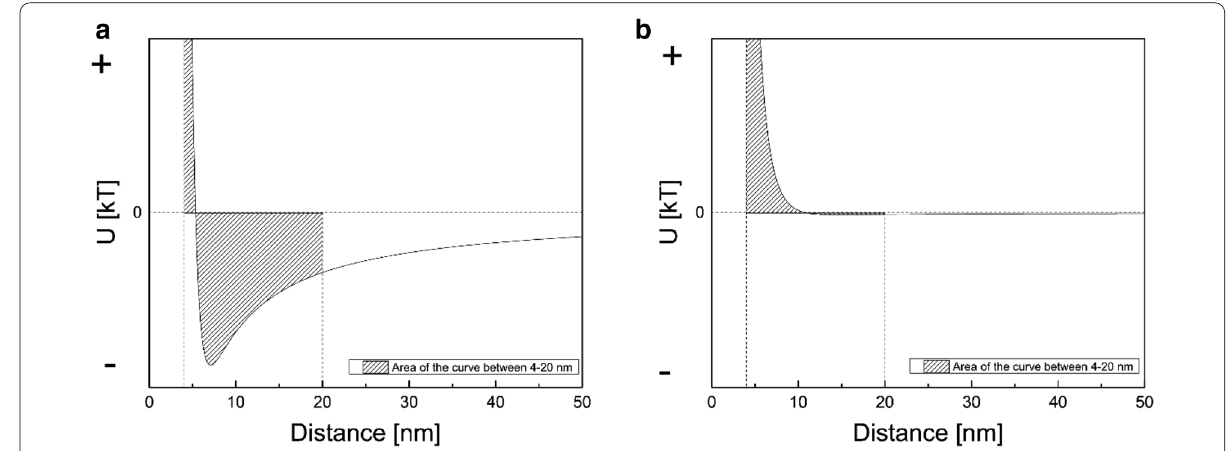
Fig. 1 Calculating area of the interaction energy curve a for attractive surfaces, b for repulsive surfaces